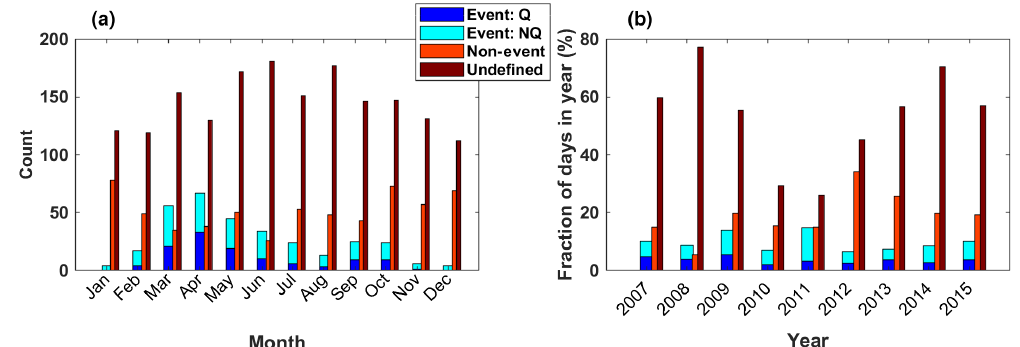
Figure 4. Monthly number (a) and yearly fraction (b) of NPF event days (divided into quantifiable events (Q) and non-quantifiable events (NQ)), non-events (NEs), and undefined days recorded in Puijo during period 2007–2015. Fraction of (e.g., NE) days in year is the ratio of number of NEs and number of days within the year. Note that the days for which bad or no data were recorded are not shown here. Note that 48 and 44% of the days are missing during years 2010 and 2012,